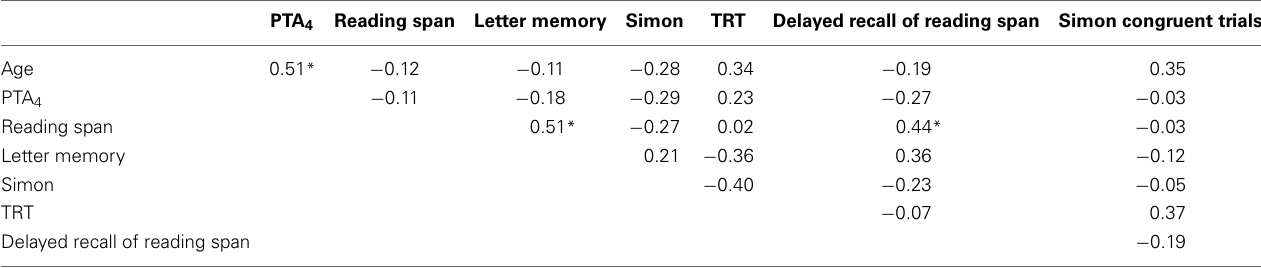
Table 2 | Coefficients of correlations (Pearson’s r) between age, average pure tone thresholds across the four frequencies 0.5, 1, 2, and 4kHz (PTA 4 ) and cognitive test scores.